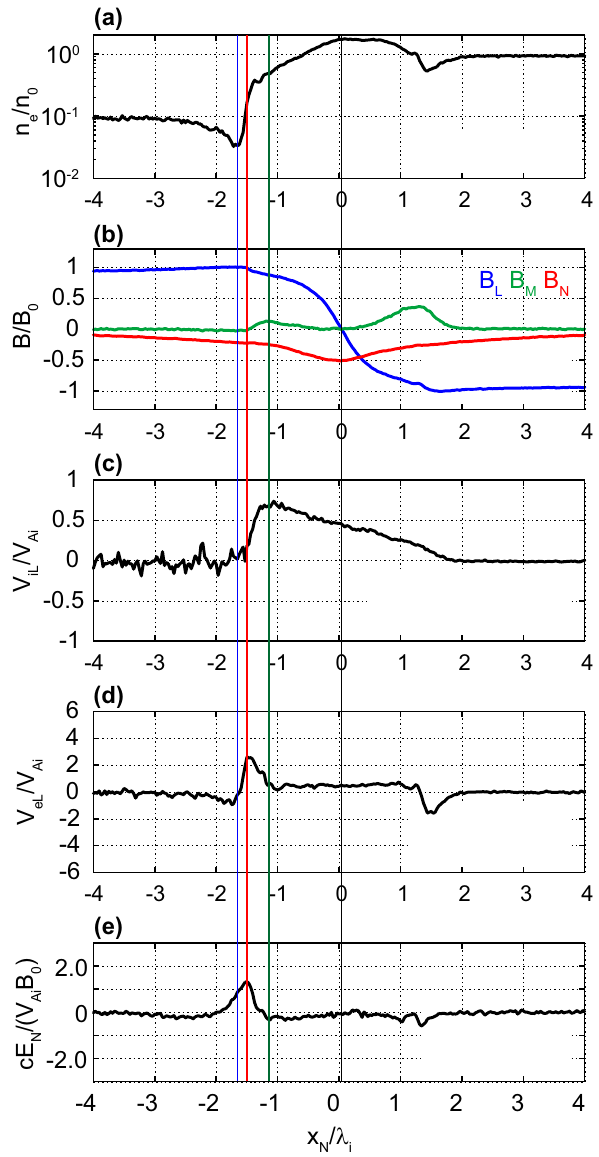
Fig. 5. One-dimensional cuts of the simulation results along x N at t =17 at x L =17.625. (a) The electron number density, (b) three components of the magnetic fields B L (blue), B M (green), and B N (red), (c) the ion outflow bulk velocity V iL . (d) the electron outflow bulk velocity V eL , and (e) the normal component of the electric field E N . The blue, red, green, and black vertical lines represent the location of the electron density dip, E N peak, V iL peak, and the B L reversal, respectively. These lines correspond to those in Fig.